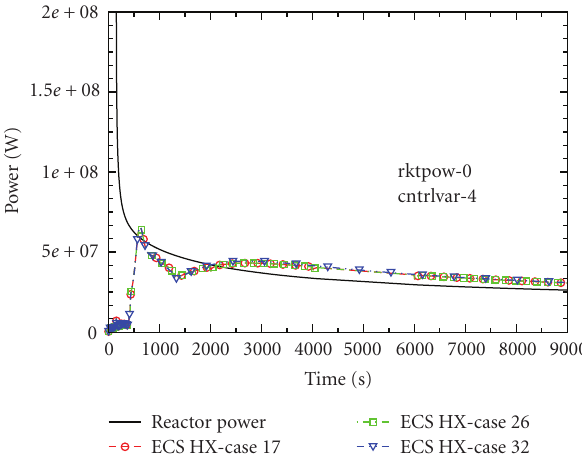
Figure 9: Reactor (solid) and guard containment (dash) pressure. Figure 10: Reactor power and heat removal rate of ECS ( t < 9000s).